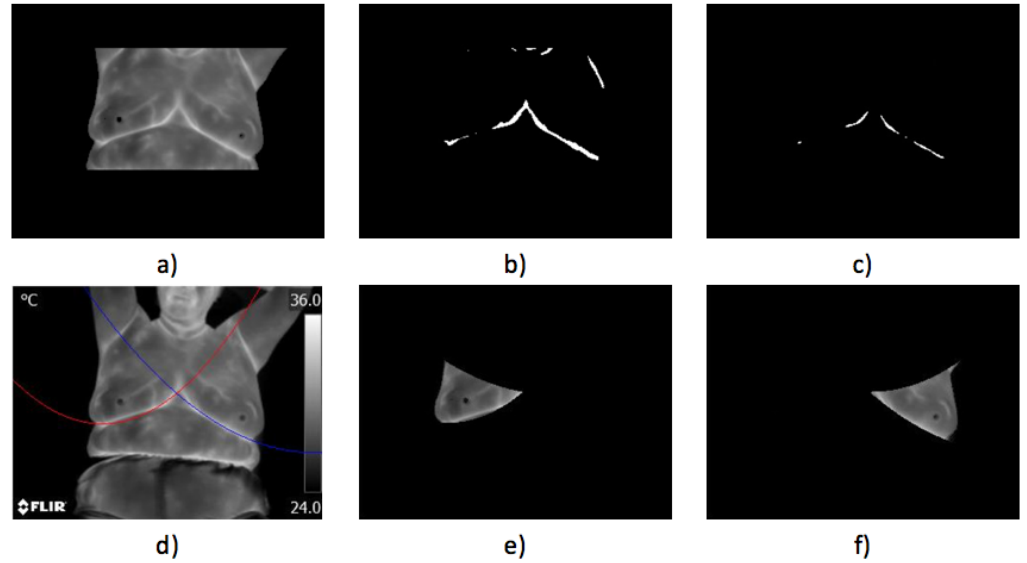
Figure 16. Case 1: ( a ) original acquired thermogram; ( b , c ) lower limit detection; ( d ) second degree polynomials; ( e ) right; and ( f ) left segmented breasts.